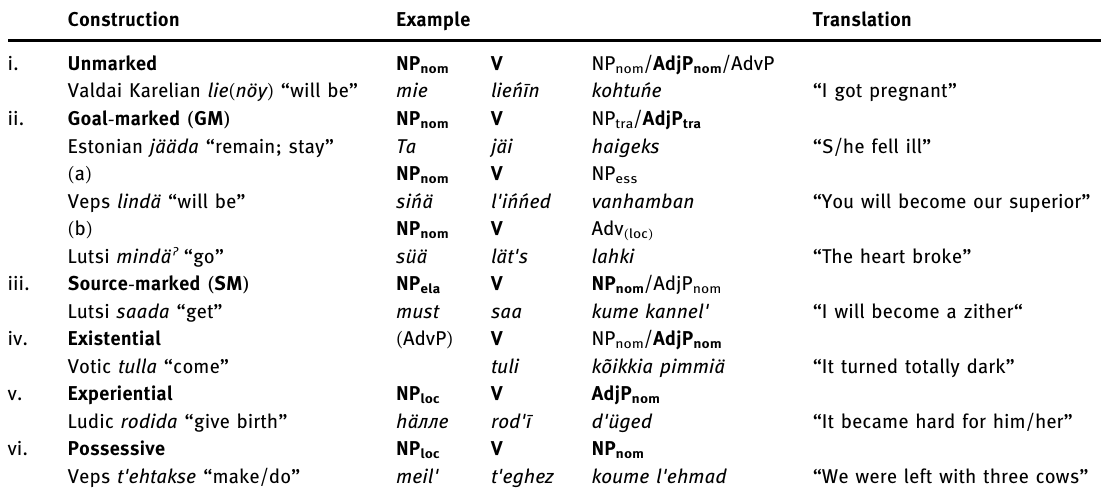
Table 2: Intransitive constructions used with CHANGE - OF - STATE predicates a